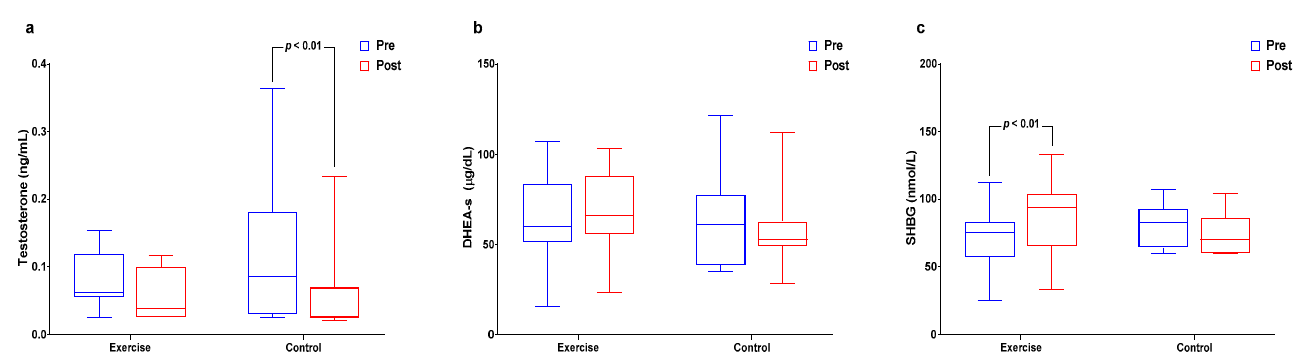
Figure 5. Effect of 12 weeks of aquatic exercise on aging-related sex hormones in elderly Korean women; ( a ) Testosterone of the control group was significantly decreased. ( p < 0.01); ( b ) DHEA-S showed significant interaction effects ( p < 0.05); ( c ) SHBG was significantly increased in the exercise group ( p < 0.01). SHBG: sex hormone-binding globulin.